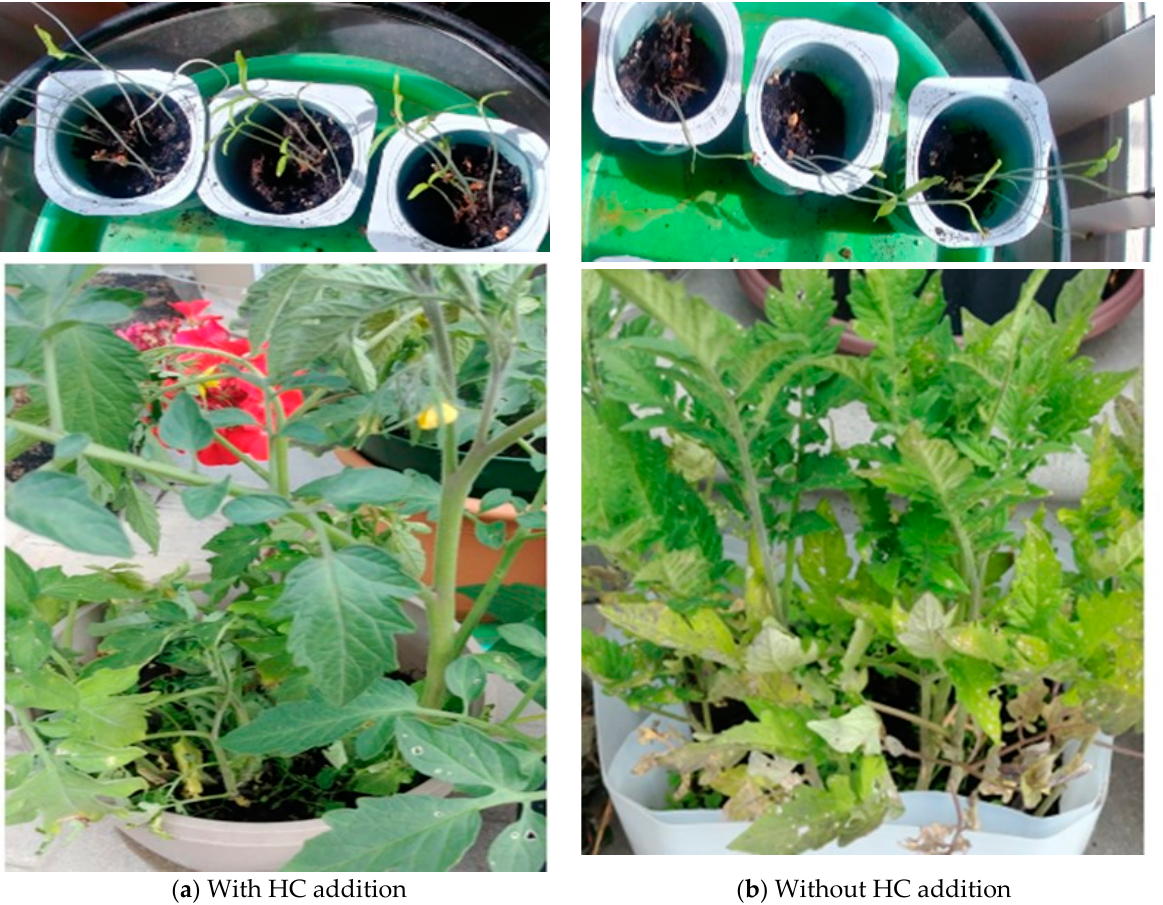
Figure 7. Tomato planting pots ( a ) with and ( b ) without hydrochar. Above are seedlings which were planted in the pots.